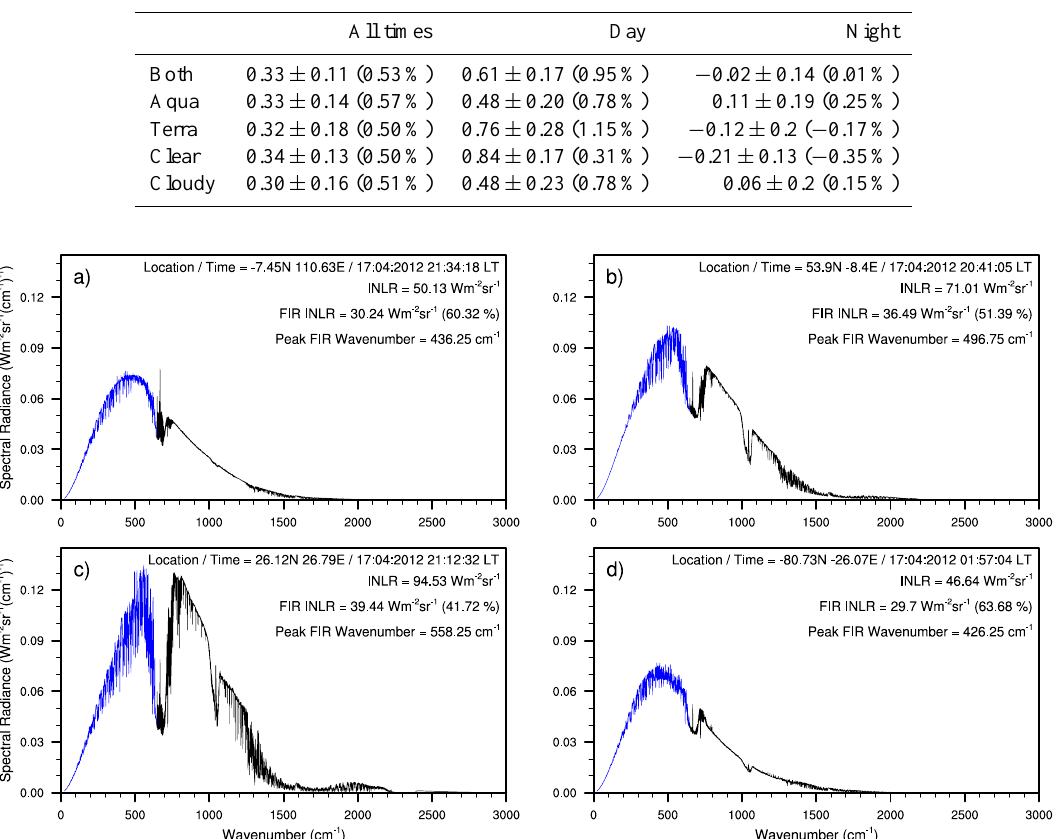
Table 1. Instantaneous biases between CERES and IASI INLR at SNO events with standard errors. Standard errors are the standard deviations divided by the square root of the total number of points. Units are Wm − 2 sr − 1 . Figures in brackets are relative differences between the bias and the mean radiation measured by both CERES and IASI.